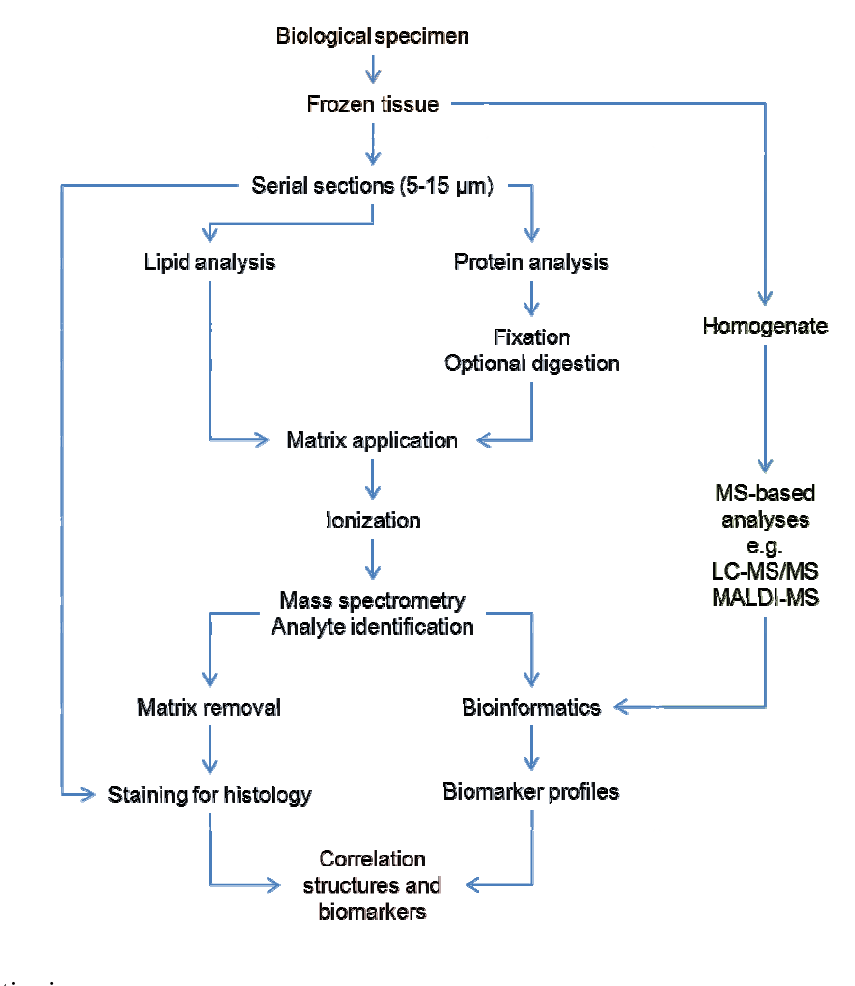
Figure 1. Workflow associated with matrix assisted laser desorption ionization-mass spectrometry imaging (MALDI-MSI) analysis, alongside complementary MS-based strategies and post-processing of data for biomarker